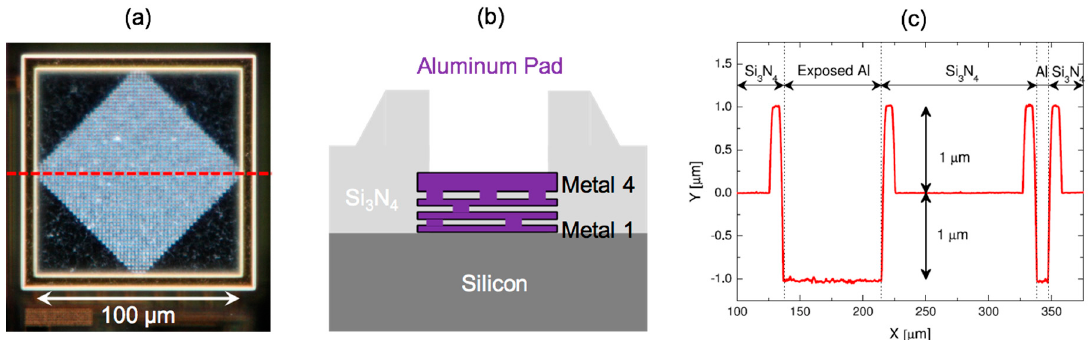
Figure 4. A dark-field micro-photograph of a standard Al bonding pad: ( a ) shows the cross-section, ( b ) shows the measured profile, and ( c ) highlights the shoulders of the passivation at the pad edges.